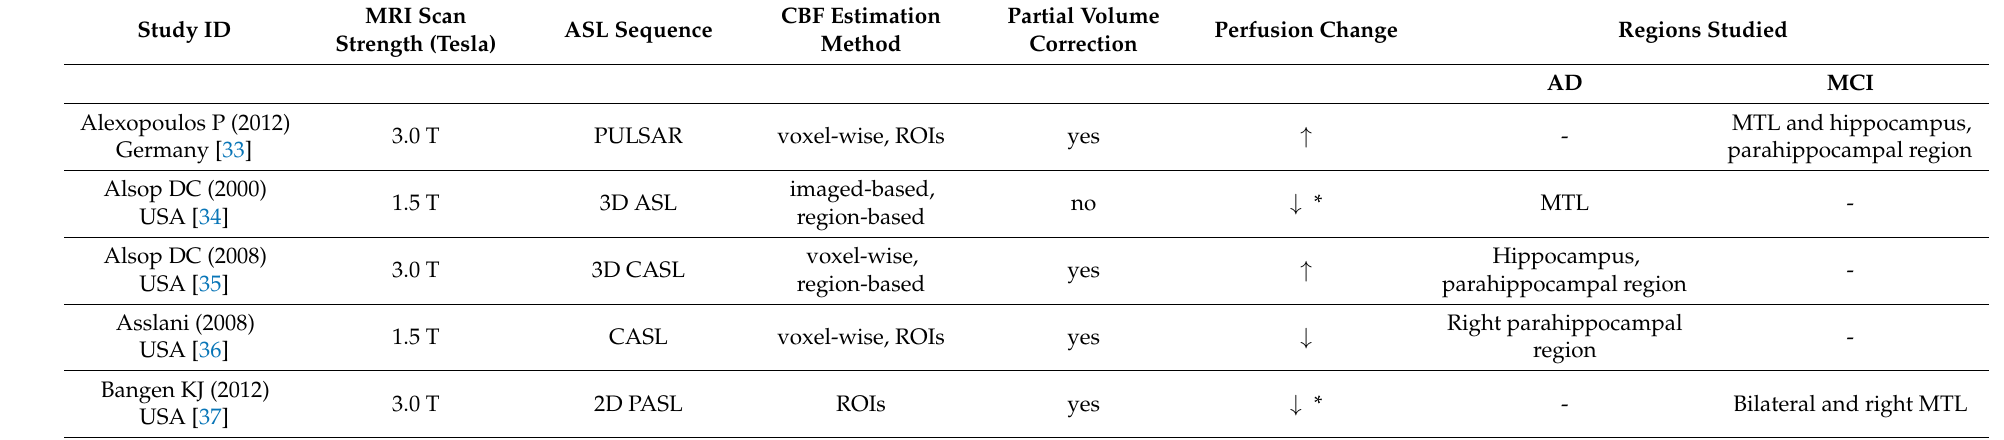
Table 2. Imaging characteristics and CBF